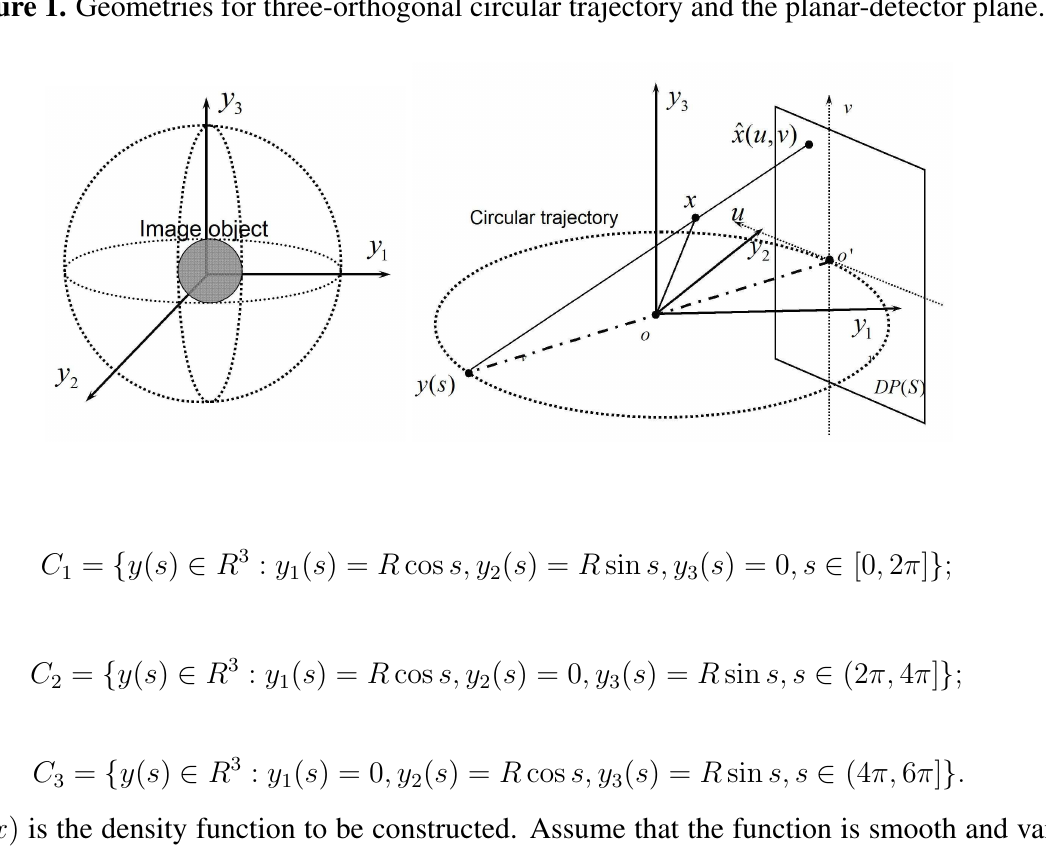
Figure 1. Geometries for three-orthogonal circular trajectory and the planar-detector